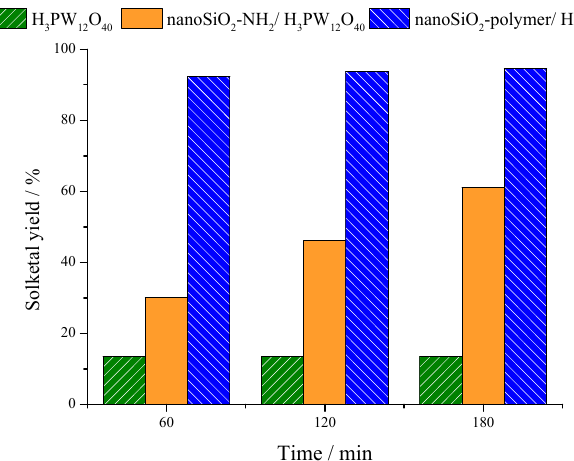
Figure 24. Solketal yield achieved in glycerol condensation with acetone over H 3 PW 12 O 40, nanodis- persed H 3 PW 12 O 40 grafted on silica nanoparticles-NH 2 , and nano-dispersed H 3 PW 12 O 40 grafted on silica nanoparticles-poly(N-methyl-4-vinylpiridium (adapted from ref. [70]). Reaction conditions: glycerol/acetone molar ratio (1:8); temperature (343 K); catalyst loading = 5.0 wt.